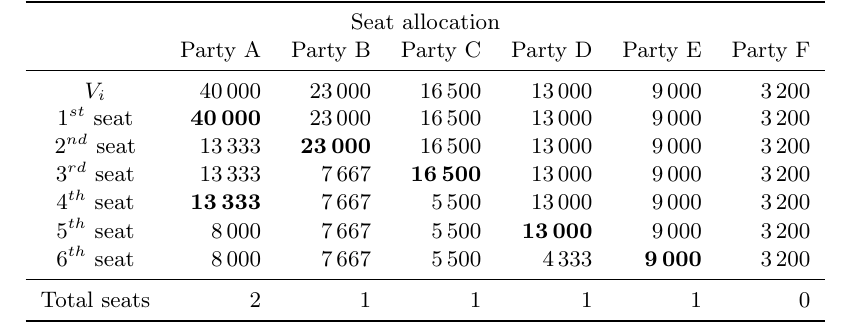
Table 2: An example of the seat allocation by means of the Sainte-Lagu¨e